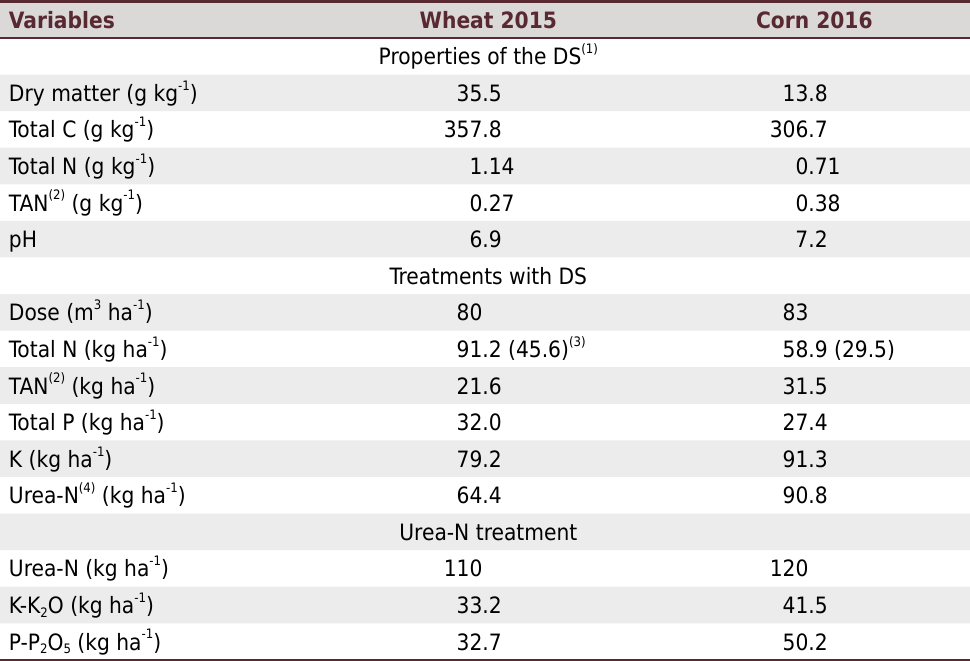
Table 1. Main properties of dairy slurry (DS) and amounts of nitrogen (N), phosphorus (P) and potassium (K) applied in the treatments with DS and Urea-N treatment in wheat and